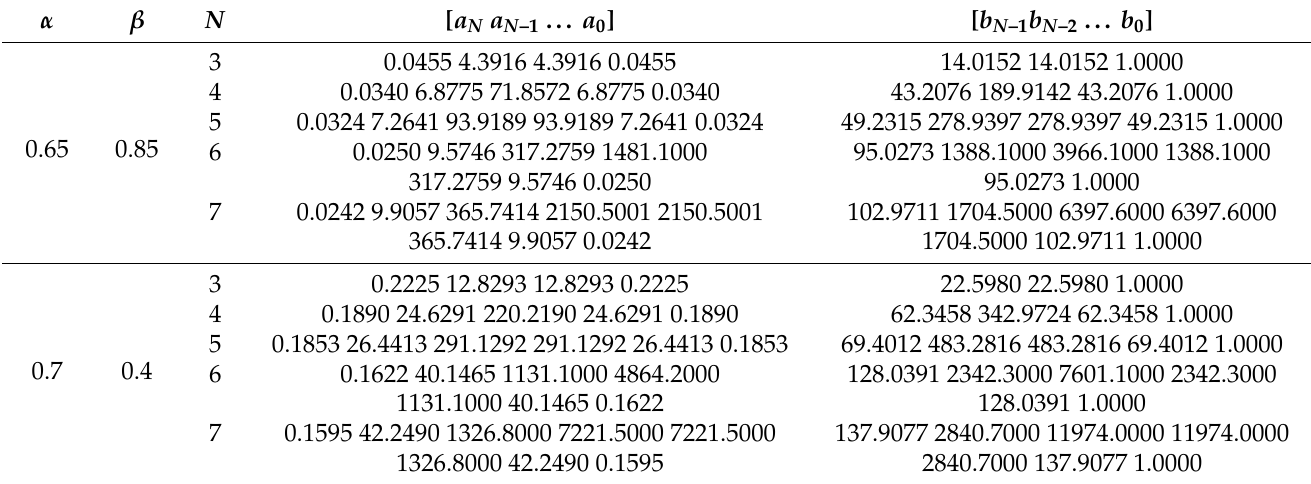
Table 6. Optimal coefficients of the proposed FBPFs for different values of α , β , and N